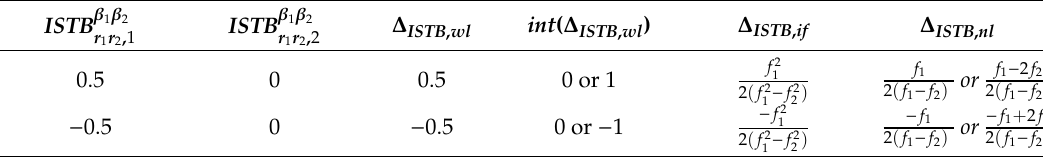
Table 3. Frequency 1 with half-cycle jump (Unit: